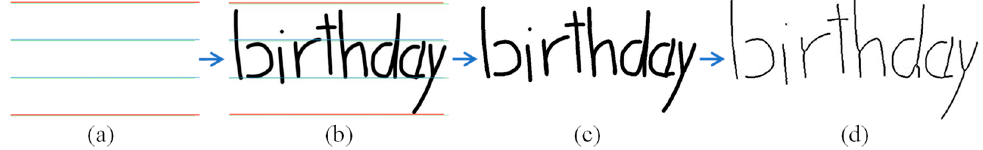
Figure 3. Pre-processing using sample image of “birthday”: ( a ) ruled writing area with four lines, ( b ) input image with handwritten word, ( c ) binarized image, and ( d ) thinned image.